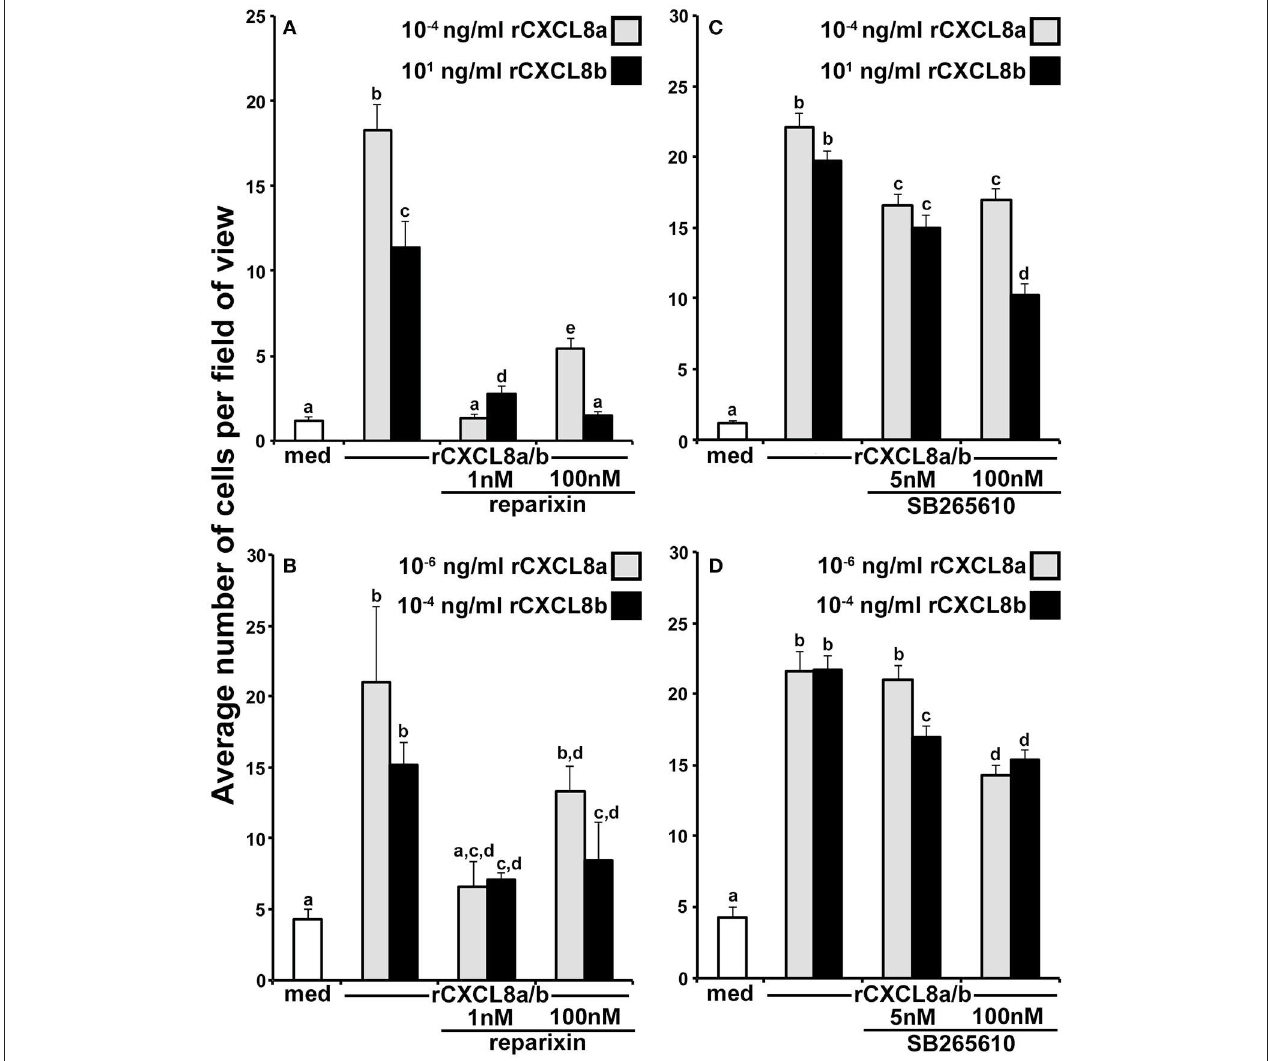
FIGURE 5 | Roles of the frog CXCR1 and CXCR2 in the rCXCL8a- and rCXCL8b-elicited chemotaxis . (A) Tadpole and (B) adult frog granulocytes (10 5 cells/well) were subjected to chemotaxis assays in absence or presence of 1nM or 100nM of the CXCR1/CXCR2 inhibitor, reparixin and using the respectively most chemo-attractive concentrations of rCXCL8 or rCXCL8b. Cells from three individual animals were used for each chemokine concentration ( N = 3). (C) Tadpole and (D) adult frog granulocytes (10 5 cells/well) were subjected to chemotaxis assays in absence or presence of 5 or 100nM of the CXCR2 inhibitor, SB265610 and using the respectively most chemo-attractive doses of rCXCL8 or rCXCL8b. Cells from four individual animals were used for each chemokine concentration ( N = 4). All results are presented as means + SEM. Above-head letters denote statistical designations: experimental groups described by distinct letters are statistically different ( P < 0.05) while those marked by the same letters are